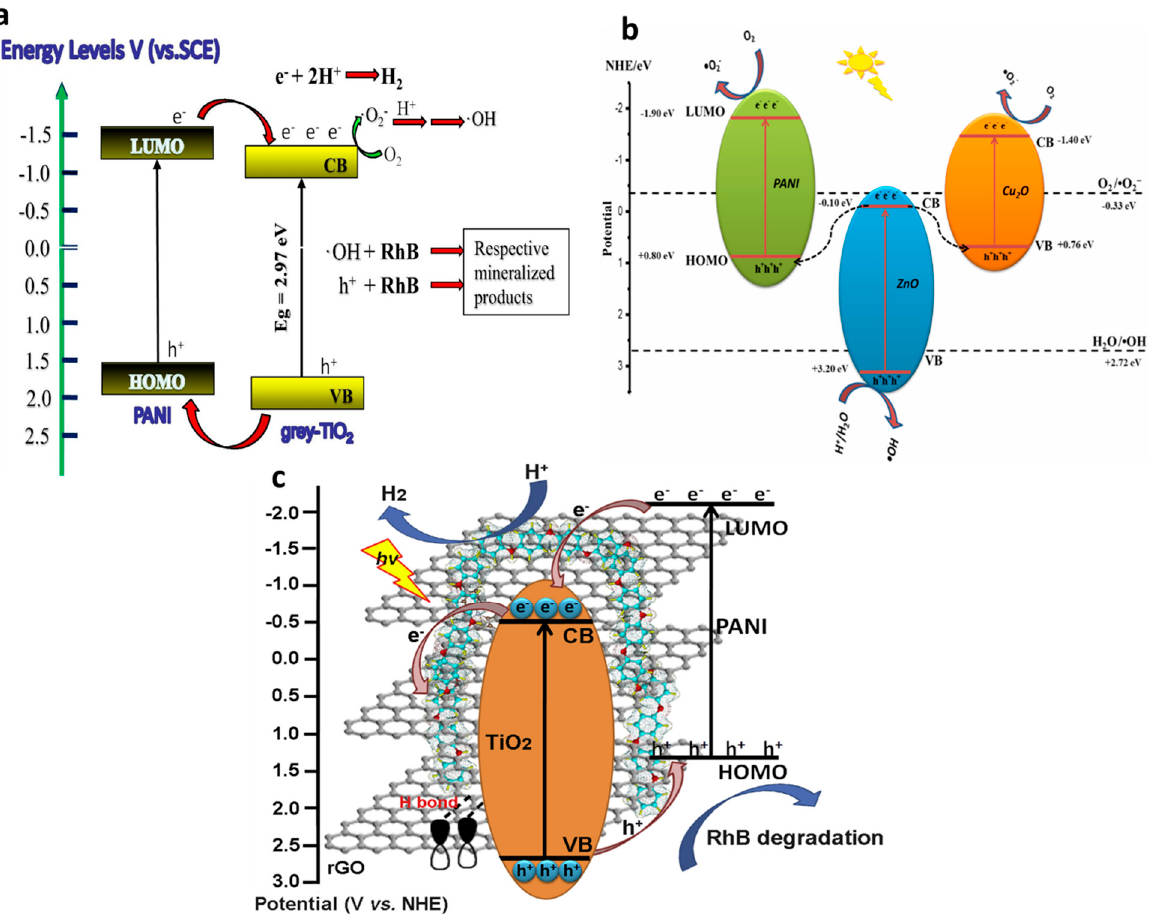
Figure 5. ( a ) Proposed mechanism for the photocatalytic degradation using a binary PANI/TiO 2 composite under visible- light irradiation [101]. ( b ) Schematic diagram of the charge transfer pathway in a ternary Z-scheme Cu 2 O/ZnO-PANI composite under visible-light irradiation [38]. ( c ) Mechanism of photocatalytic activity of ternary PANI/TiO 2 /rGO composite